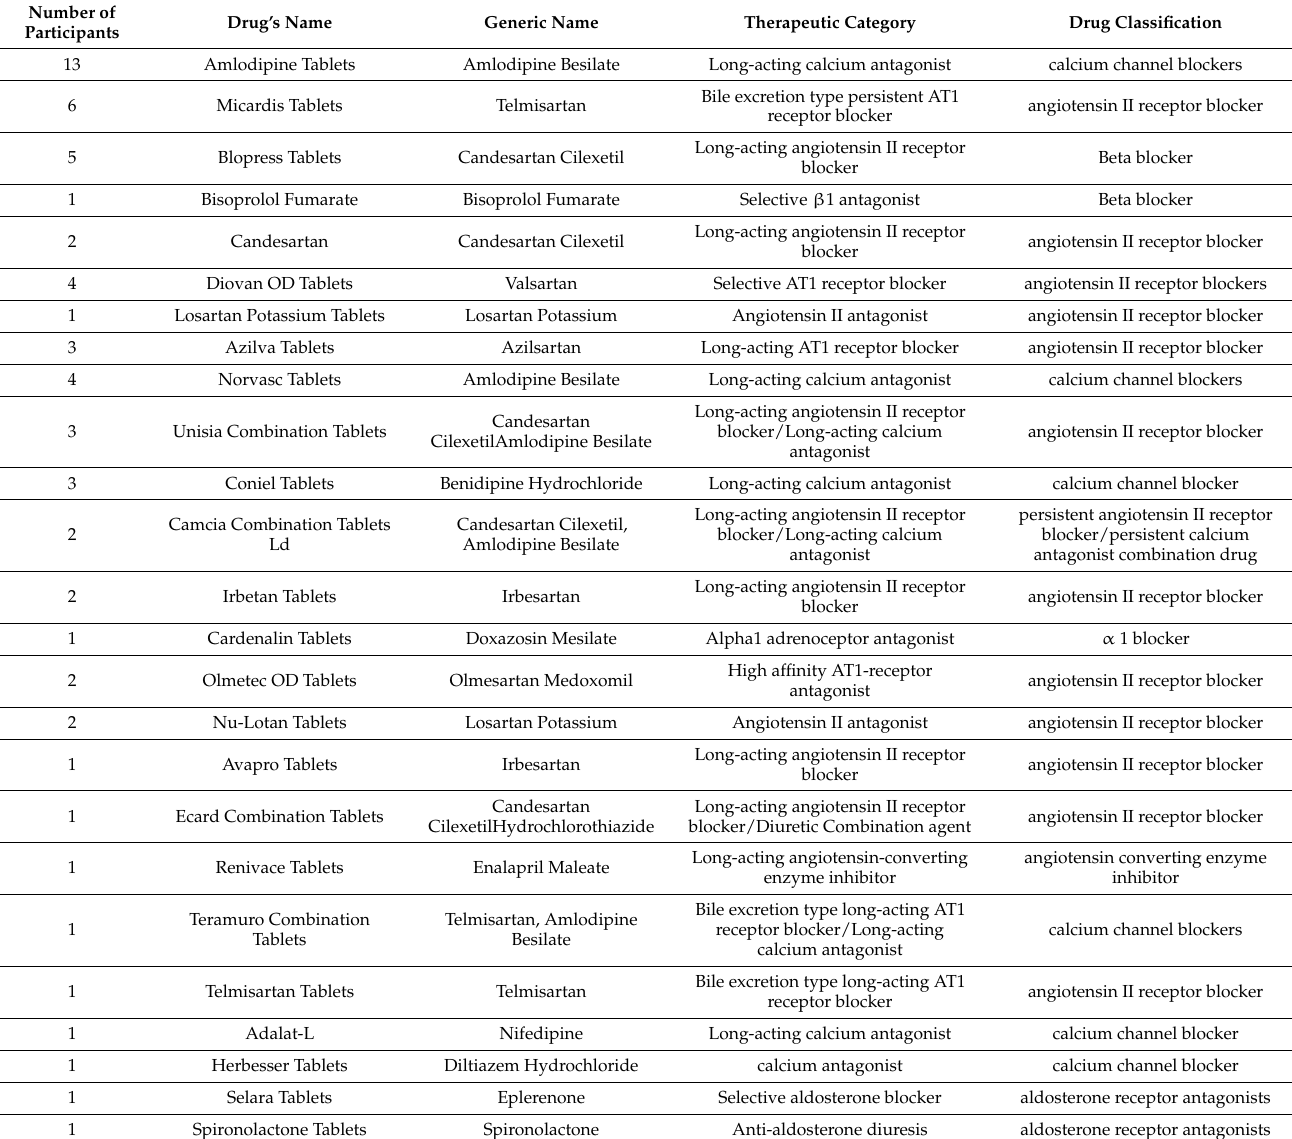
Table A1. List of the Antihypertensive